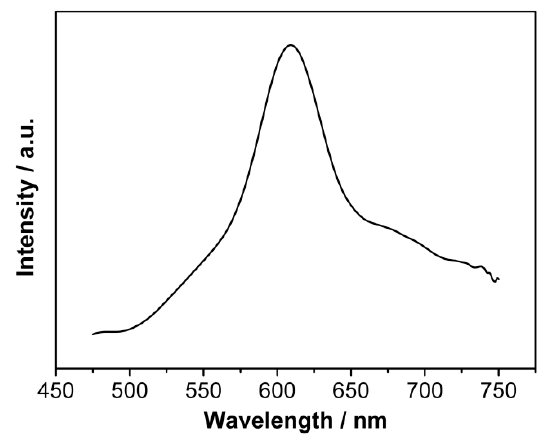
Figure 5. Solid-state emission spectrum for 1 at room temperature (excited at 316 nm).